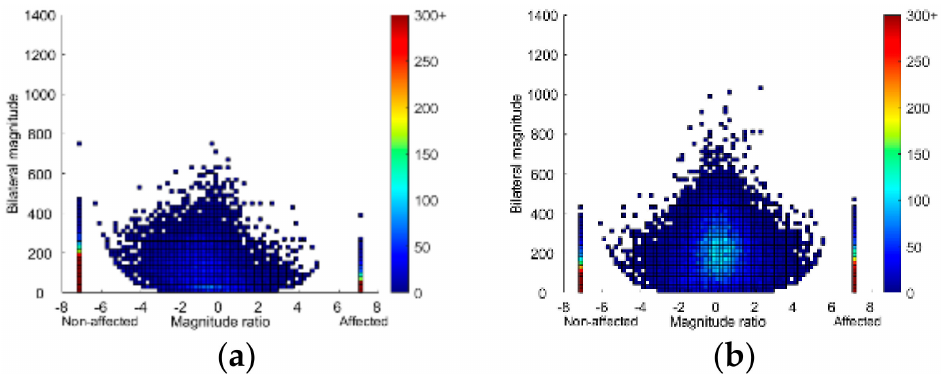
Figure A1. Density plots showing 24 h of upper limb activity for a single person in the ( a ) mismatch group (Fugl-Meyer Assessment upper extremity FMA-UE = 58, hand domain of the Stroke Impact Scale SIS-Hand = 25) and ( b ) good match group (FMA-UE = 59, SIS-Hand = 80), plotted on a second- by-second basis. The magnitude ratio (x-axis) indicates contribution of each limb to activity. The bilateral magnitude (y-axis) indicates the activity intensity. The color represents frequency, with brighter colors indicating greater frequencies. Bars at − 7 and 7 show unilateral unaffected and affected UL activity,